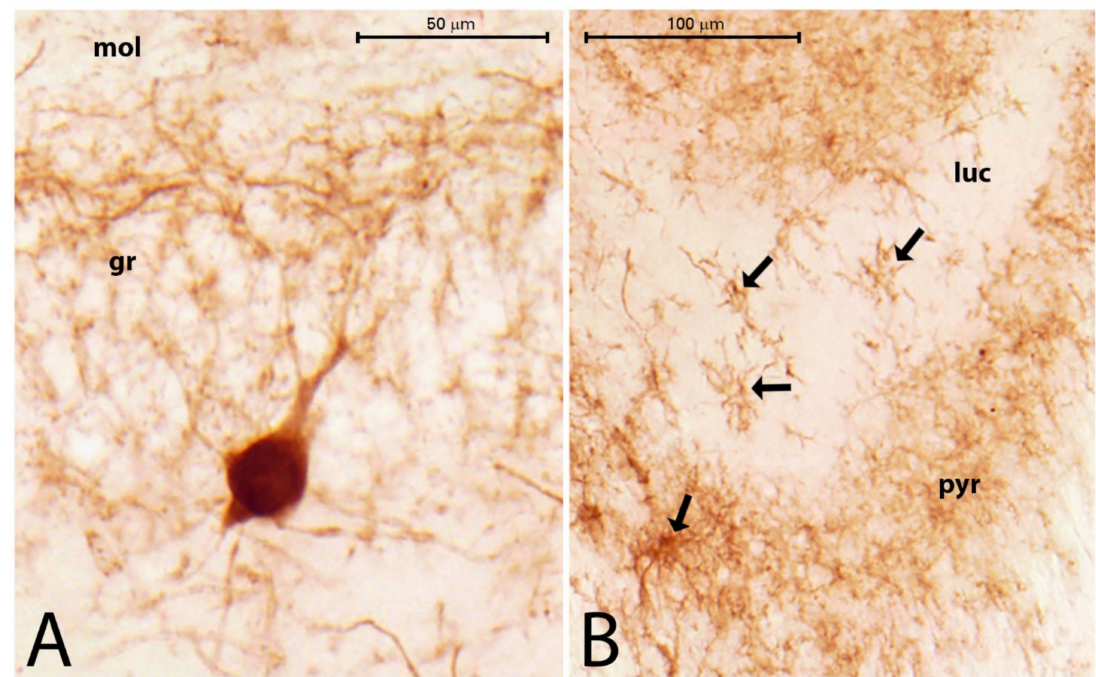
Figure 6. ( A , B ) PV-stained structures in PT4 ( A ) and PT7 ( B ), with a PV-stained neuron between the neurons of the DG granular layer (gr). The fine pericellular PV network is visible (mol = molecular layer of DG; bar = 50 µ m). PV-stained astrocyte-like cells (black arrows) are visible in the stratum lucidum (luc) and stratum pyramidale (pyr) of CA3 in PT7 (bar = 100 µ m).